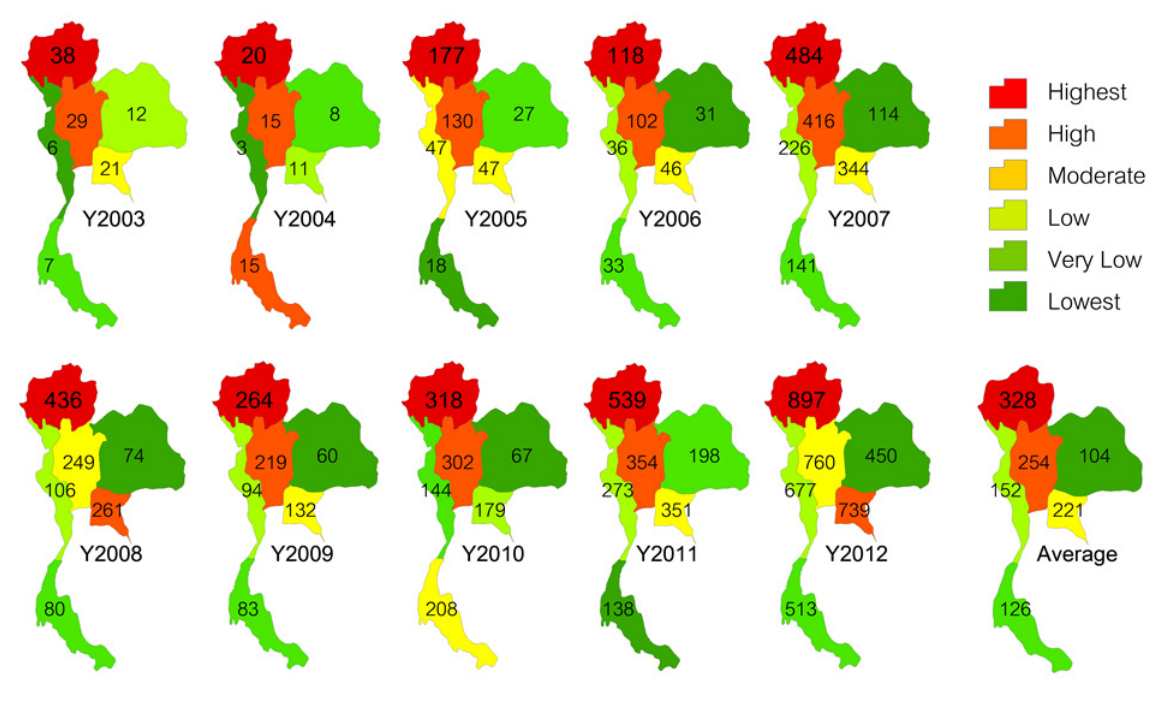
Figure 1. HFMD outbreaks in number of patients per million inhabitants at the regional level, annually from 2003 to 2012 and the 10 year